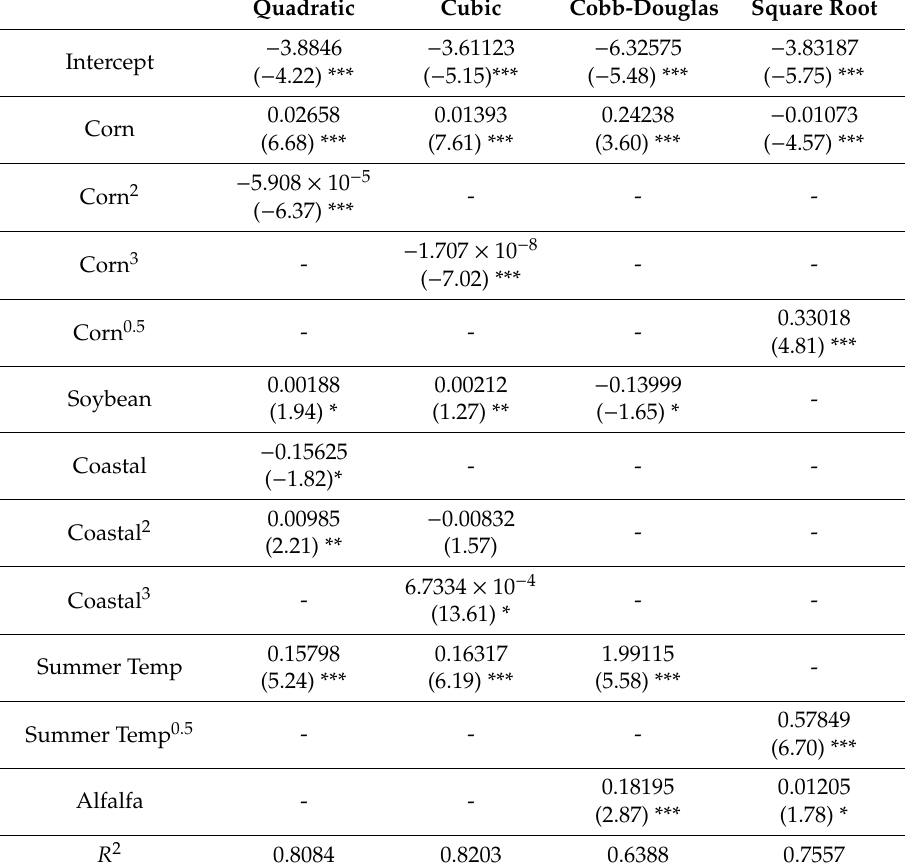
Table 3. Parameter estimates for all functional